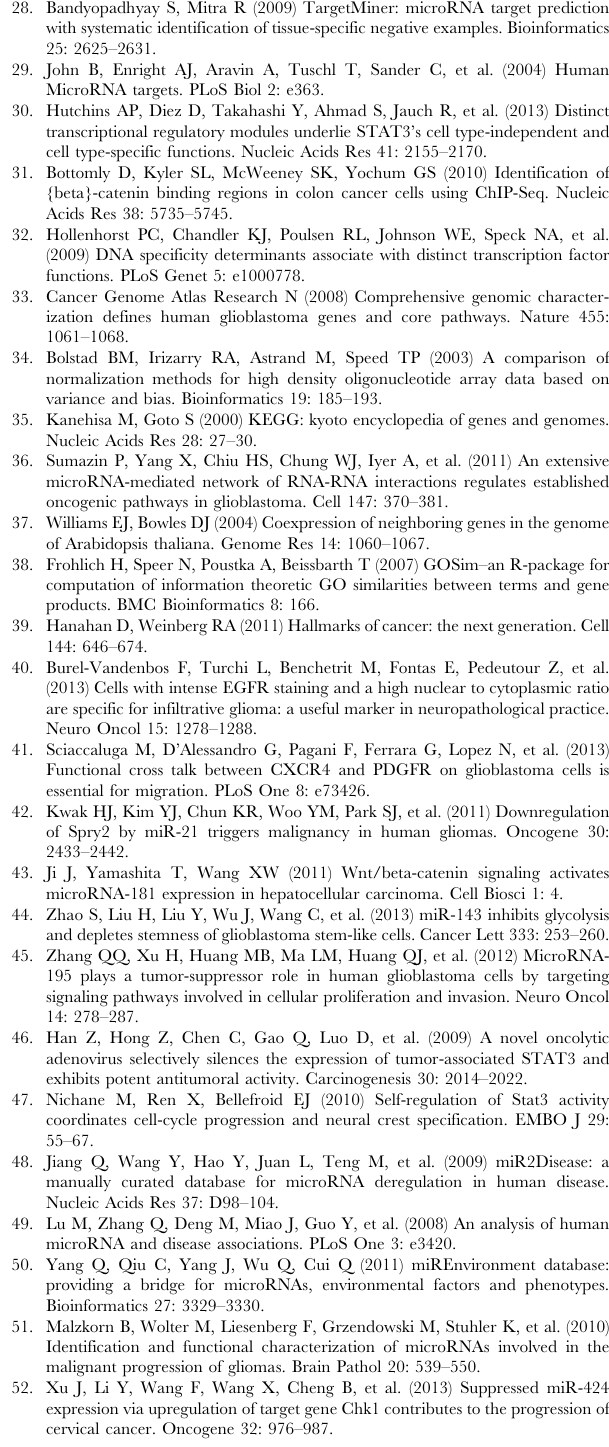
Table S1 MiRNA and mRNA signatures of each miRNA- pathway regulation in the core module of the MPRN. Table S2 Cox regression analyses of module signature, age, and karnofsky performance score (KPS) in the glioblastoma patient